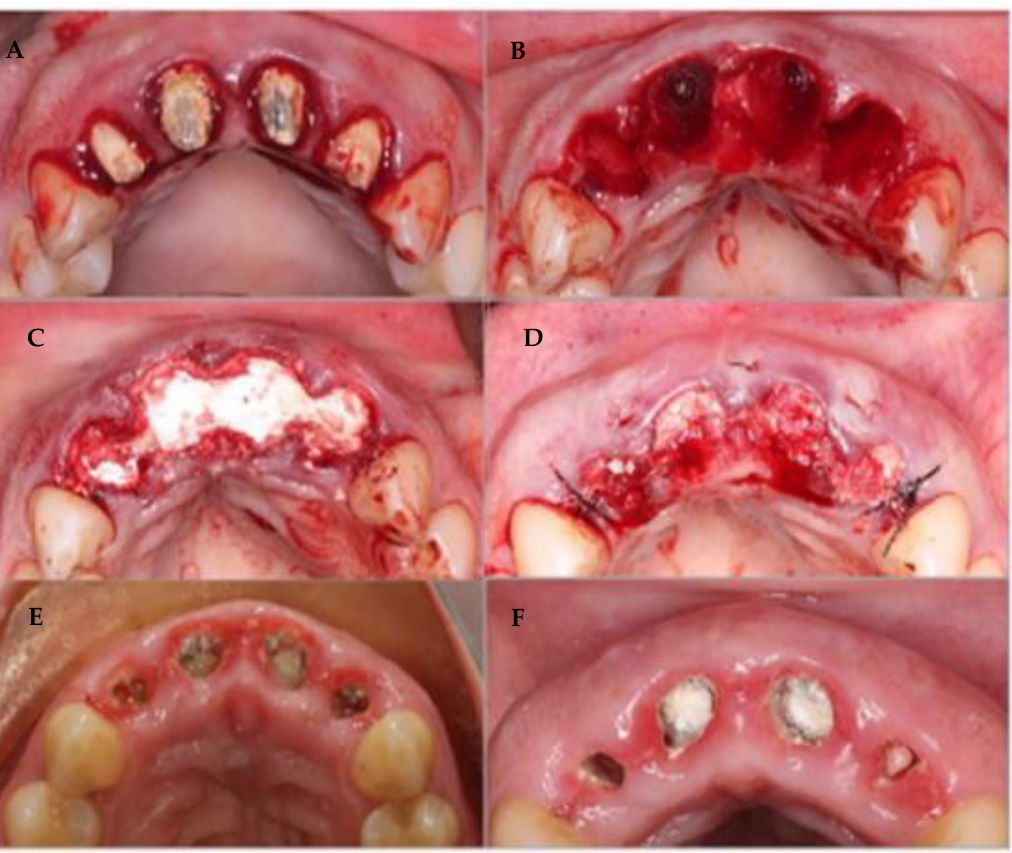
Figure 15. ( A ) Preoperative occlusal view; ( B ) Dental extractions; ( C ) Placement of Bond Apatite ® ;